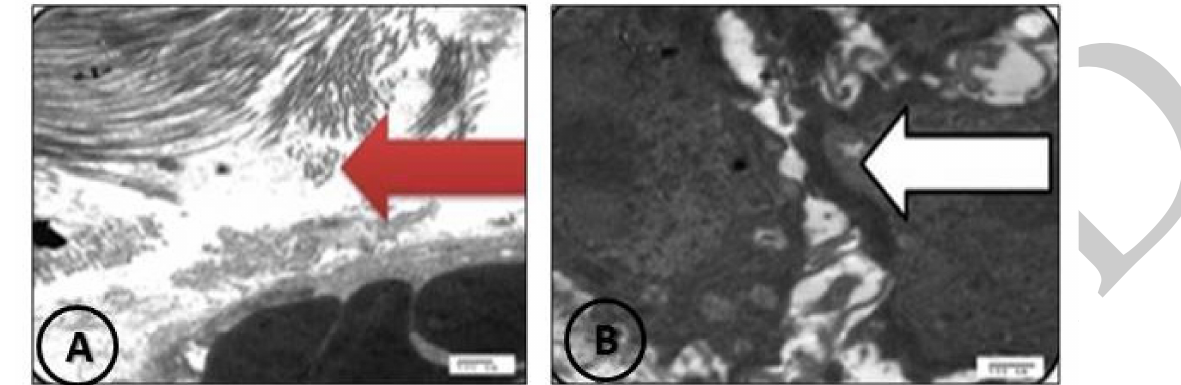
Figure 14. Ultrastructure sections of the untreated diabetic group and the diabetic group treated with the C. molle extract. ( A ) Untreated diabetic deep wound group showing ruptured dermal layers (red arrow). ( B ) Treated diabetic deep wound group with C. molle extract showed restoration of almost all dermal